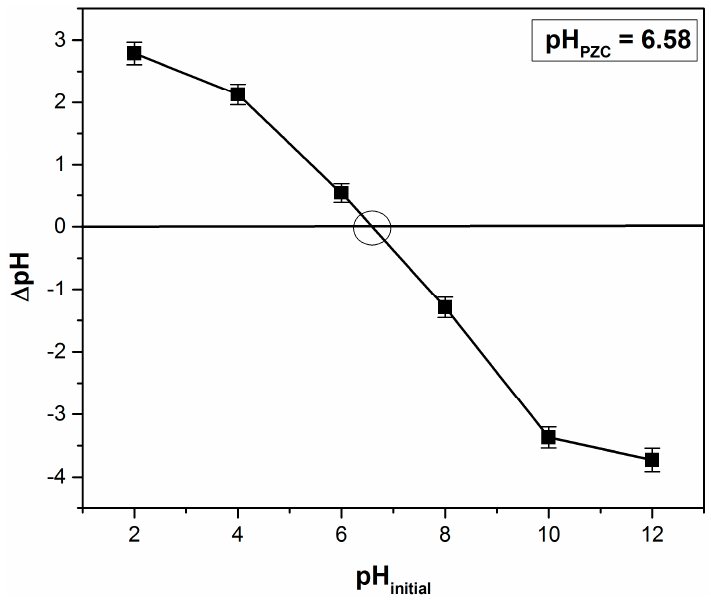
Figure 2. Determination of point of zero charge (pH PZC ) based on the solid addition method.